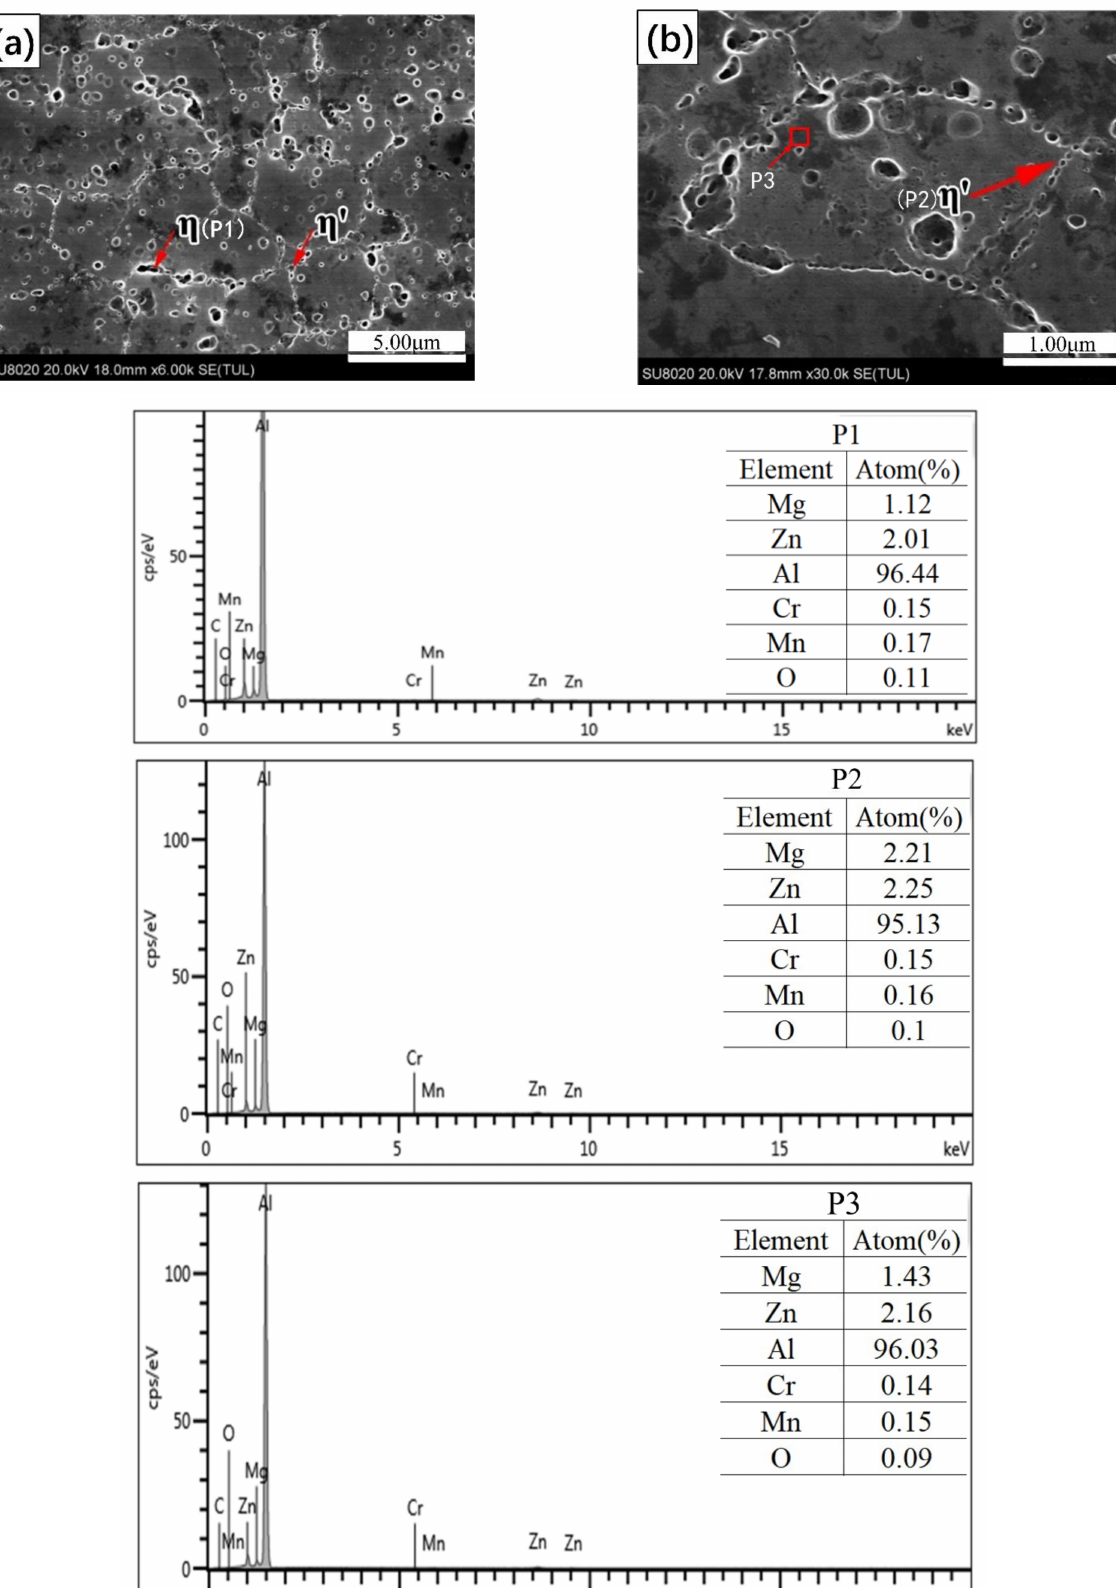
Figure 2. The microstructure morphology and EDS analysis of the 7N01 extrusion aluminum alloy after non-isothermal aging: ( a ) SEM images under 6k magnification; ( b ) SEM images under 30k